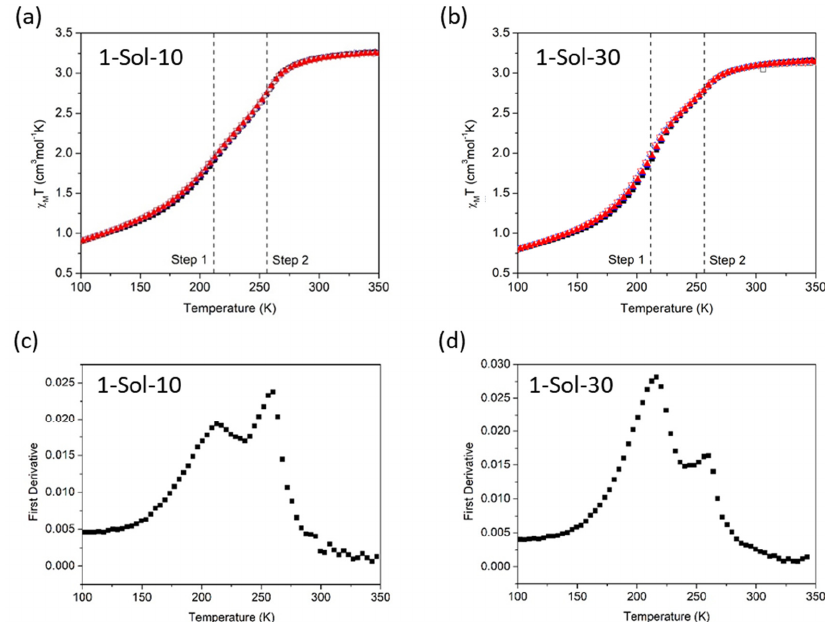
Figure 5. Plots of χ M T vs. T for compound three cycles, with the stepped transitions indicated by dashed lines. First cycle: heating ■ , cooling ☐; second cycle: heating ▲ , cooling ∆ ; third cycle: heating ▼ and cooling ∇ ( a ) 1-Sol-10 ( b ) 1-Sol-30 . First derivative of 2nd heating cycle. ( c ) 1-Sol-10 and ( d ) 1- Sol-30 . Table 1. Spin crossover (SCO) properties determined by SQUID magnetometry for 1-Sol, 1-Mech, 1- BM10 and 1-BM90.